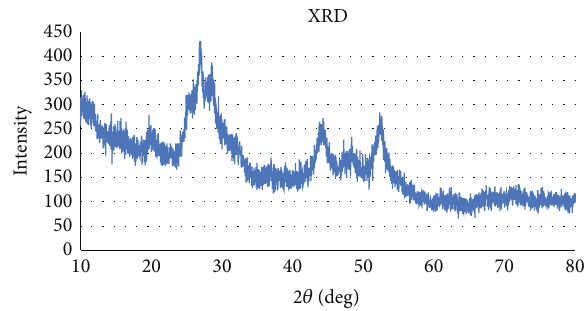
Figure 3: XRD spectra of the catalyst